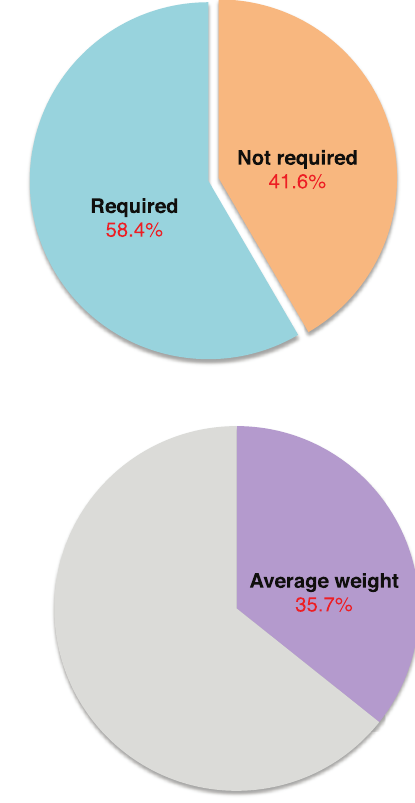
Figure 6. Scientists think more scientific projects should not be asked about their practical outcome potential. ( A ) Graph shows how surveyed scientists responded to the following question: “What percentage of public funding should be allocated to basic biological/ biomedical research proposals in which discussing the potential of future health benefits to society is not required?”. 290 answered the question; 14 skipped. ( B ) Graph shows how surveyed scientists responded to the following question: “With regard to basic biological/ biomedical research proposals in which discussing the potential of future health benefits to society is required, what average weight should be given to this potential in assigning scores for funding decisions?” 285 answered the question; 19 skipped. 17.3% in some disagreement and 8.7% in complete disagreement (Figure